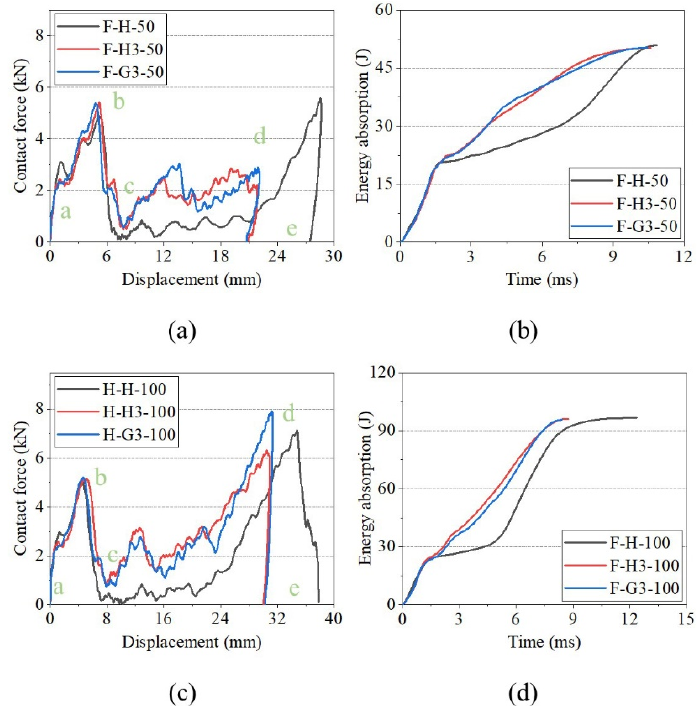
Figure 17. Impact responses of H, H3, and G3 with flat impactor. (a) Contact force–displacement curves of 50J. (b) Energy-absorption curves of 50J. (c) Contact force–displacement curves of 100J. curves of 50 J. ( b ) Energy-absorption curves of 50 J. ( c ) Contact force–displacement curves of 100 J. (d) Energy-absorption curves of 100J. ( d ) Energy-absorption curves of 100 J.